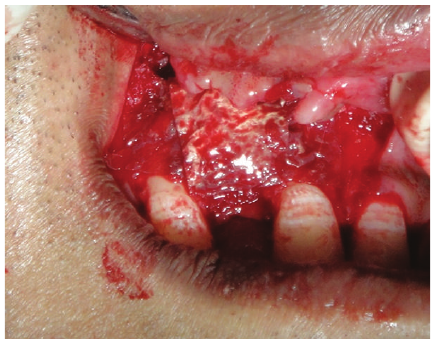
Figure 11: Implant placed in the augmented site.